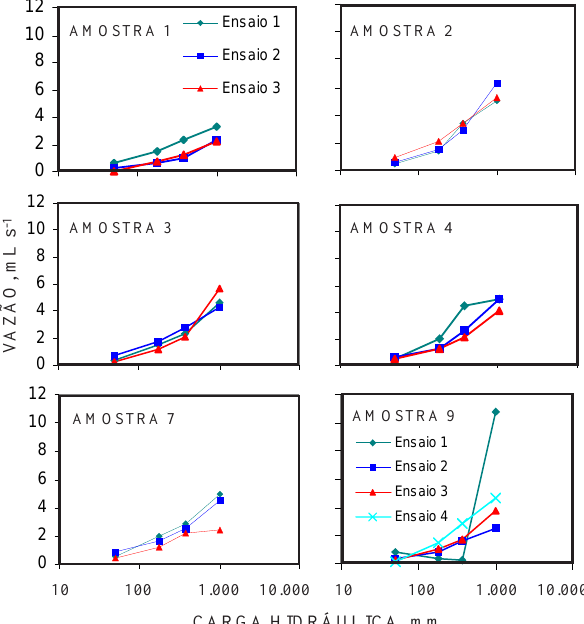
Figura 4. Vazão decorrente da carga hidráulica nos ensaios de furo de agulha dos saprolitos menos erodíveis.